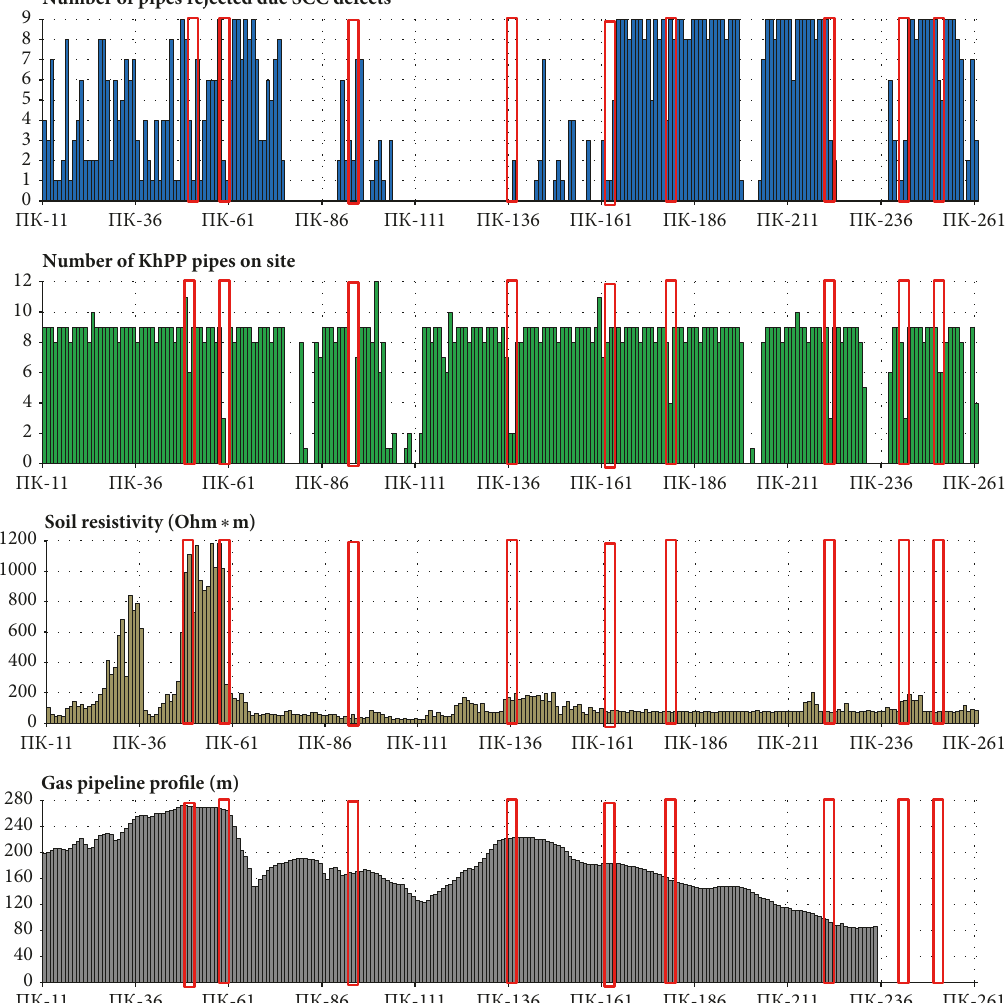
Figure 6: Number of pipes with SCCdefects, numberof KhPP pipes, soil characteristics,and section profile. The X-axis indicatesthe distance along the pipeline route. Pipeline sections with a small number of pipes produced by KhPP are marked in red.